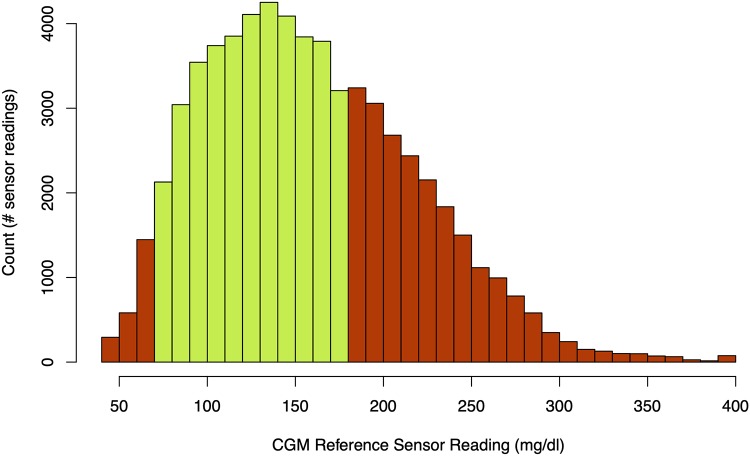
Frequency histogram showing counts of CGM sensor readings for all patients in the training data.Different colours indicate whether or not the sensor reading is normoglycemic or not.